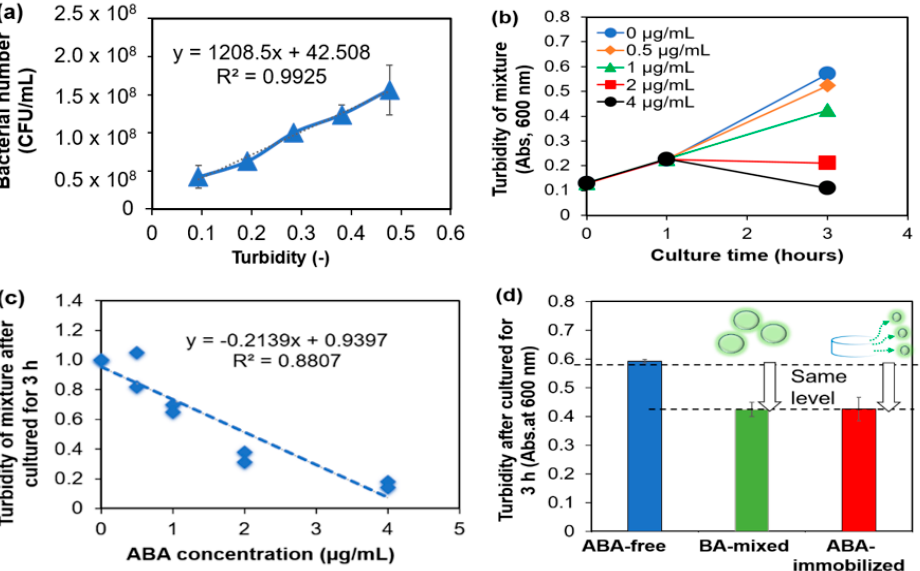
Figure 3. ( a ) Calibration curve of the number of E. coli (CFU / mL) and the turbidity value; ( b ) temporal change of the turbidity at different concentrations of the ABA; ( c ) calibration curve of the turbidity and the concentration of the ABA after three hours; and ( d ) evaluation of the activity of the ABA in free, mixed, and immobilized cases.